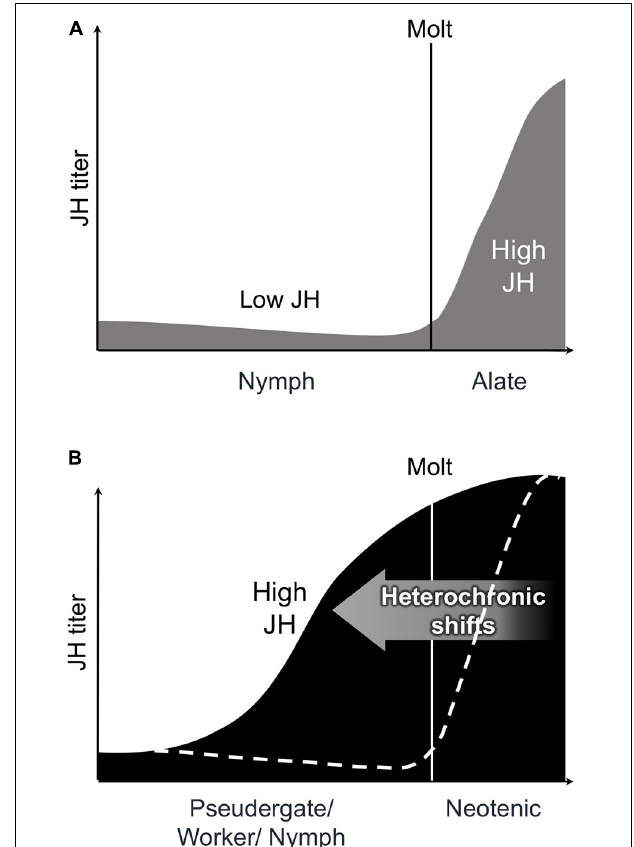
FIGURE 3 | Schematic illustrations of models on the transitions of juvenile hormone (JH) titer (vertical axis) during alate or neotenic differentiation. (A) Consistently-lowered JH titer lead alate molt from nymphal instar. After alate molt, the JH titer rise in female alates. Figures were modified as per Cornette et al. (2008, Figure 7). (B) JH titer ransition from low to high leads the neotenic differentiation. Dotted line indicates the JH titer during alate